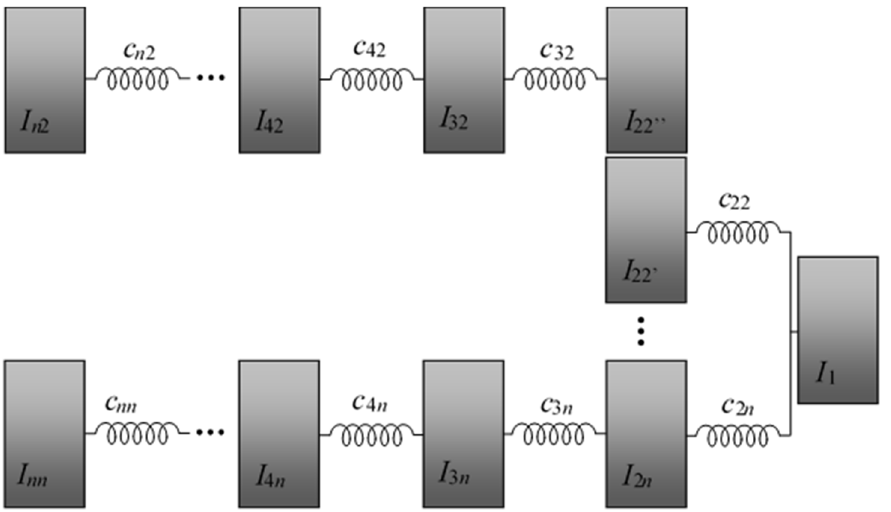
Figure 6. Model of the drive system including the first decoupling. The process described by Equations (24)–(30) is continued until decoupling of the